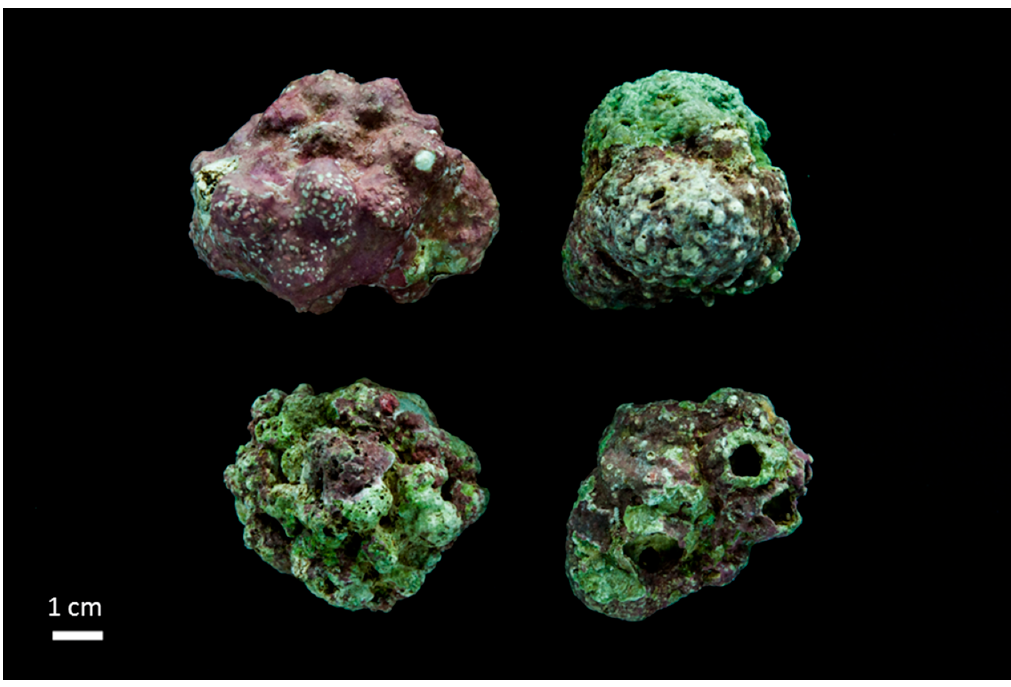
Figure 4. High resolution photographs of the rhodoliths collected by dredge sampling from 40 m depth off the Kei River mouth, South Africa.